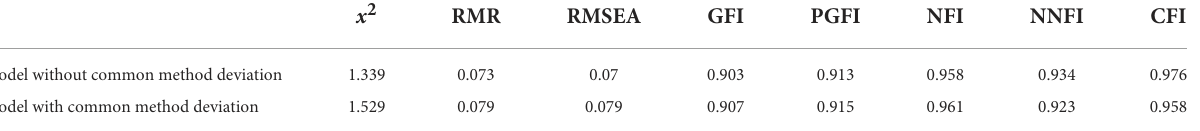
TABLE 3 Analysis of common method